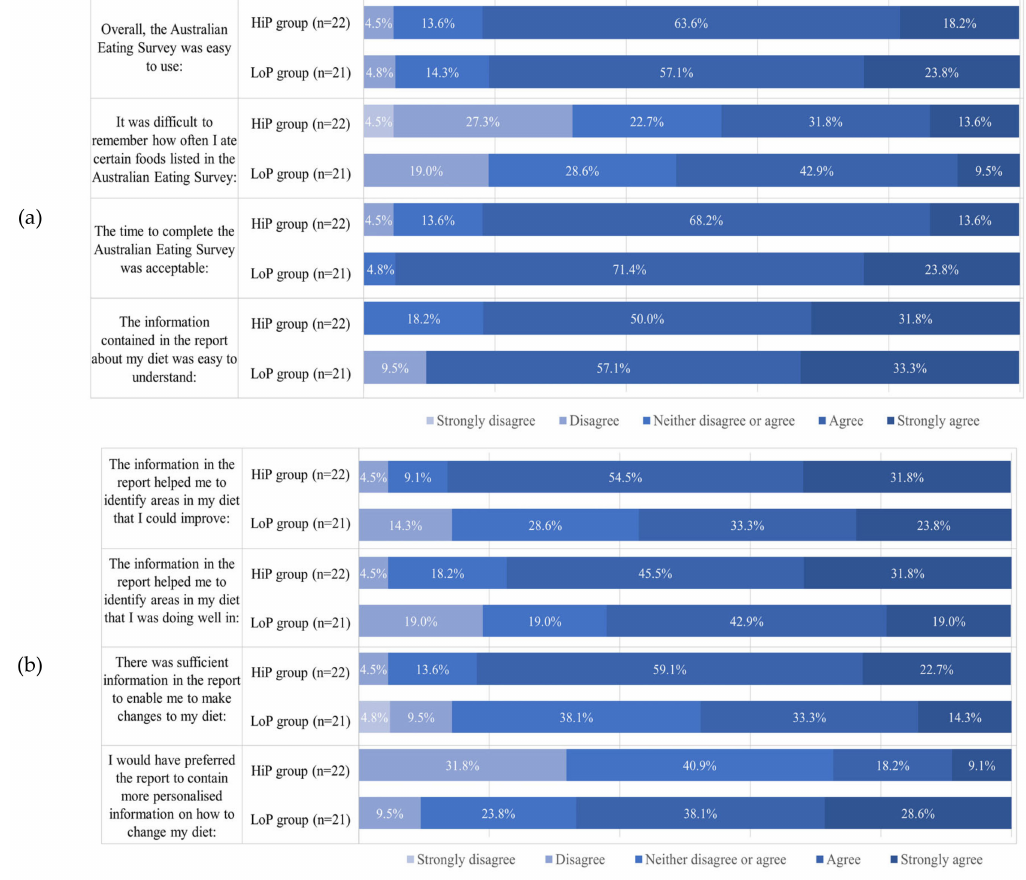
Figure 3. Participant feedback on the AES ( a ) and associated dietary feedback report ( b